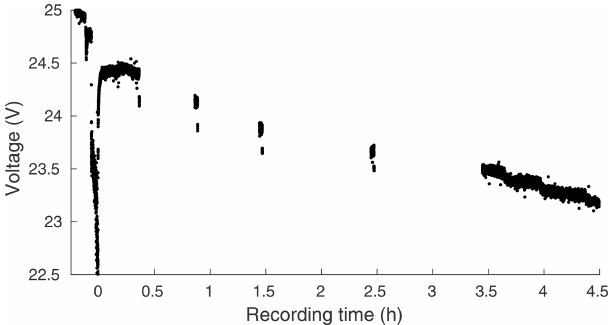
Figure A1. Voltage of the UAV’s batteries during and after the flight ( t = 0 corresponds to the landing time). The flying period ( t < 0) is characterized by a drop in voltage. The voltage during the non- flying period ( t > 0) is discontinuous as the data were monitored by telemetry only intermittently. If the time evolution of the volt- age was extrapolated linearly, the critical value of 21.5V would be reached after ∼